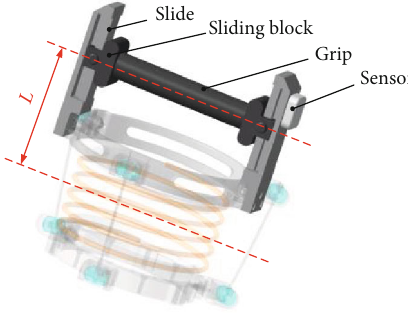
Figure 3: Structure of the adjustable handle part.